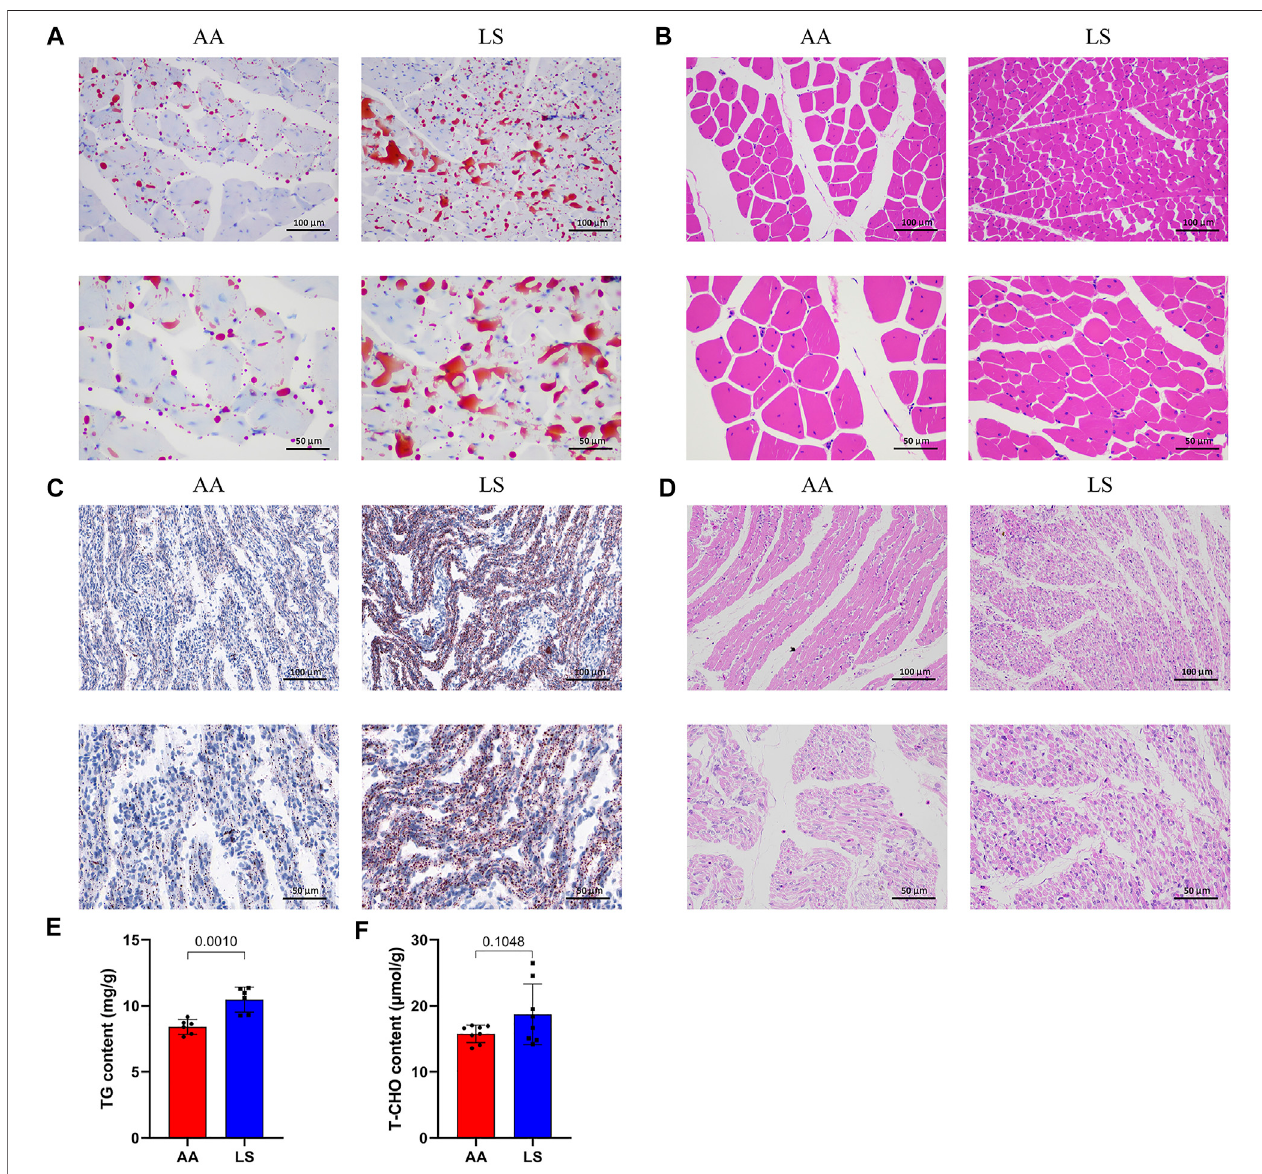
FIGURE 1 | IMF deposition and fi ber diameter in LS chicken breast muscle compared with AA broiler. (A) The difference in lipid droplet accumulation in the breast musclesof5-week-oldAAbroilerandLSchickenasdeterminedbyoilredOstaining. (B) Thedifferenceinbreastmuscle fi berdiameterinthebreastmusclesof5-week- old AAbroiler and LSchickendeterminedbyHEstaining. (C) Thedifference inlipiddroplet accumulationinthebreastmusclesofone-day-old AAbroilerand LSchicken determined by oil red O staining. (D) The difference in breast muscle fi ber diameter in the breast muscles of one-day-old AA broiler and LS chicken determined by HE staining. Scale bar: 100 μ m (20X), 50 μ m (40X). (E,F) The concentrations ofTG and T-CHO, respectively, in the breast muscle of AAbroilerand LS chicken ( n (cid:1) 8 for each group).